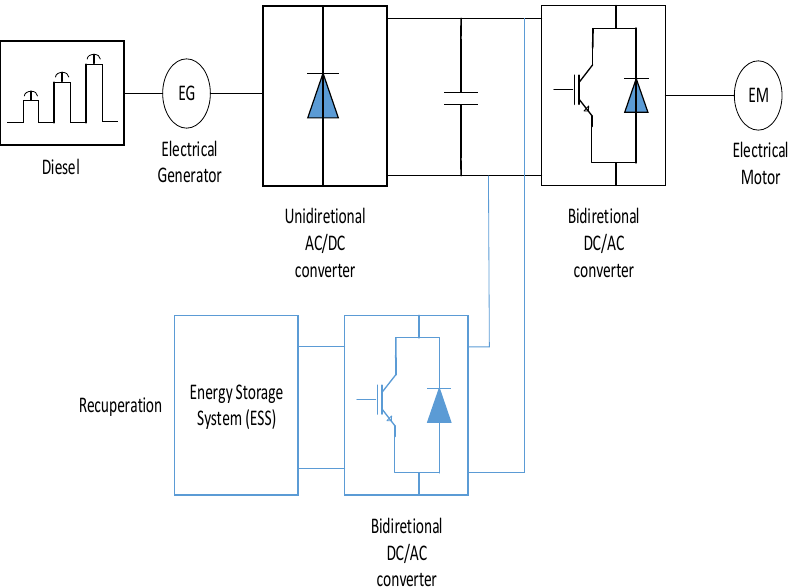
Figure 3. Block diagram of diesel–electric traction with an energy recuperation system [35].